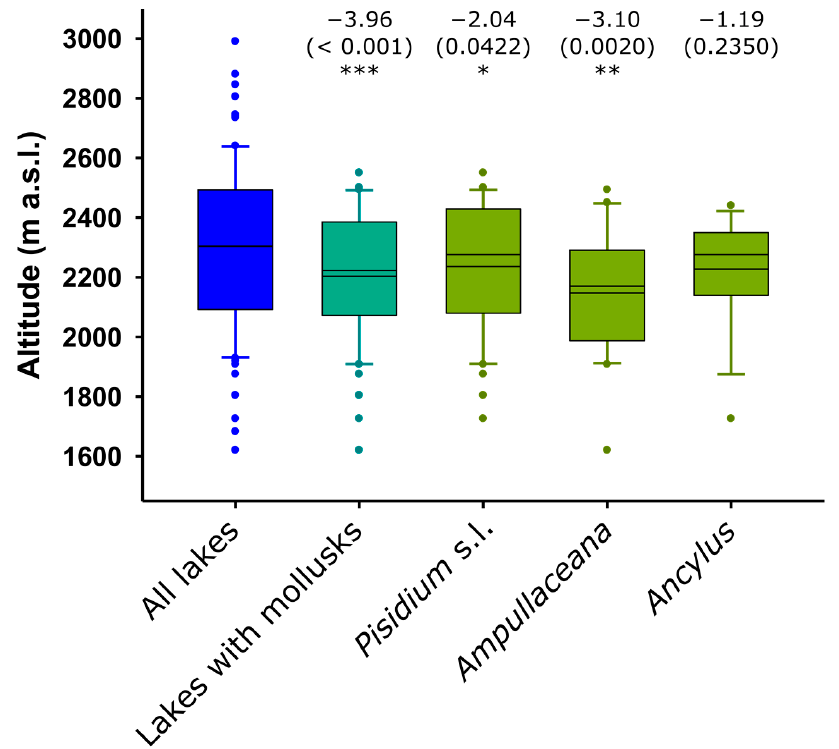
Figure 2. Altitudinal distribution of mollusk compared to the distribution of the survey lakes. Significance ( p -values) refers to Mann–Whitney tests ( z -scores) comparing altitude values in lakes with and without the taxon being considered. Asterisks indicate the level of significance: *, p < 0.05; **, p < 0.01; ***, p < 0.001. The mean and median are shown within the boxes; the larger the distance between them, the higher the skewness of the data. Table 2. Relationship between geographical and environmental